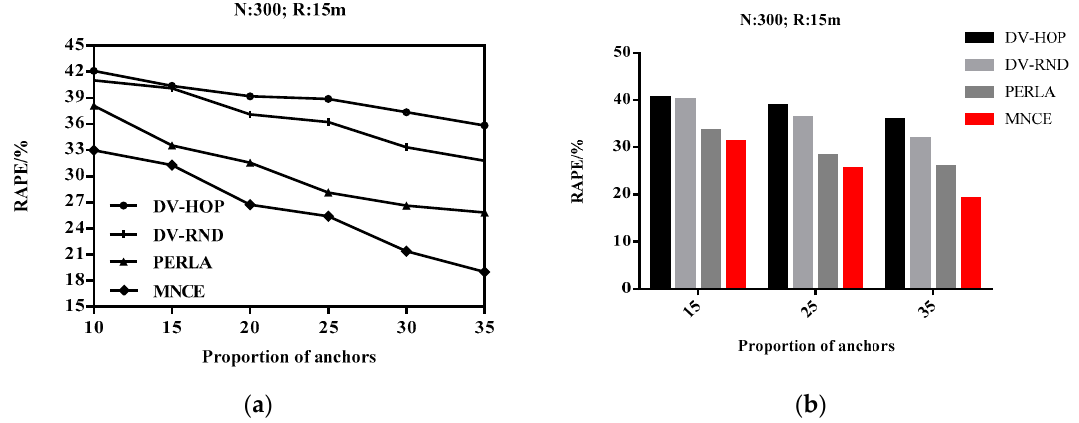
Figure 11. Impact of POA on RAPE . ( a ) broken line diagram of the experimental results; ( b ) histogram of experimental significance values.